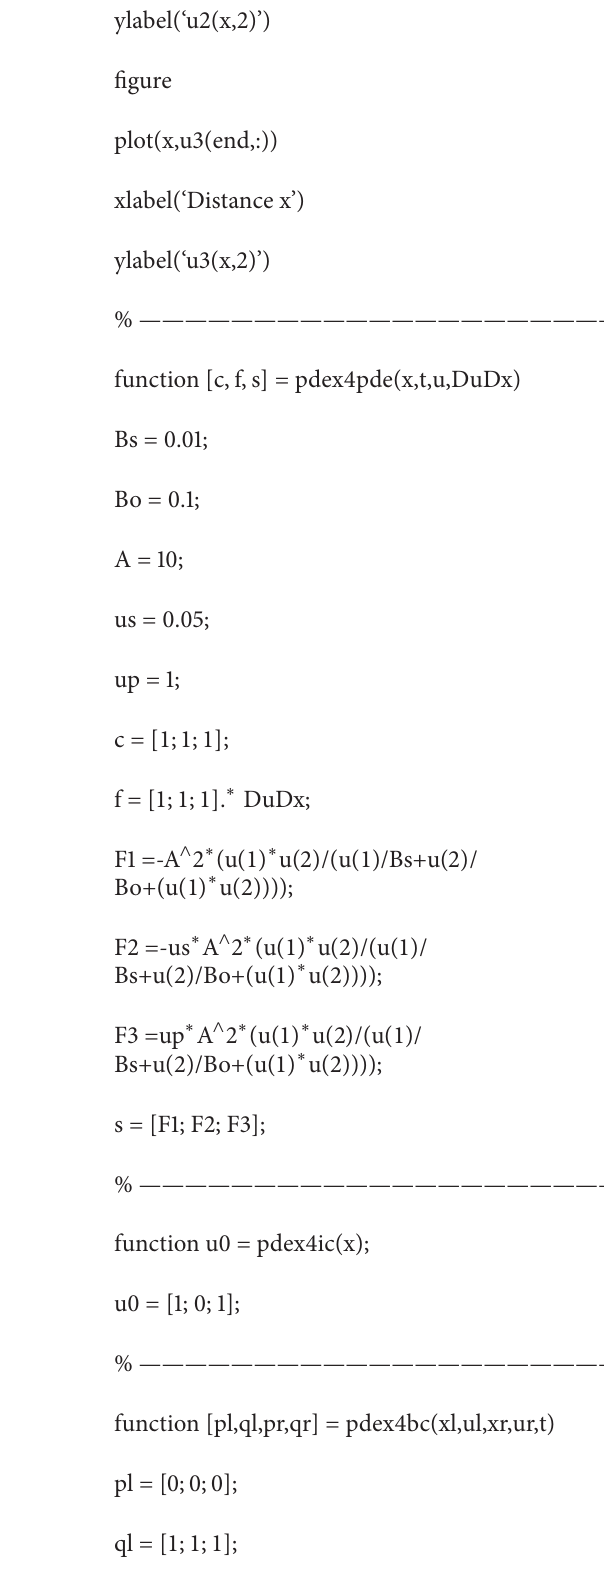
plot(x,u1(end,:)) xlabel(‘Distance x’) ylabel(‘u1(x,2)’) plot(x,u2(end,:)) xlabel(‘Distance x’)